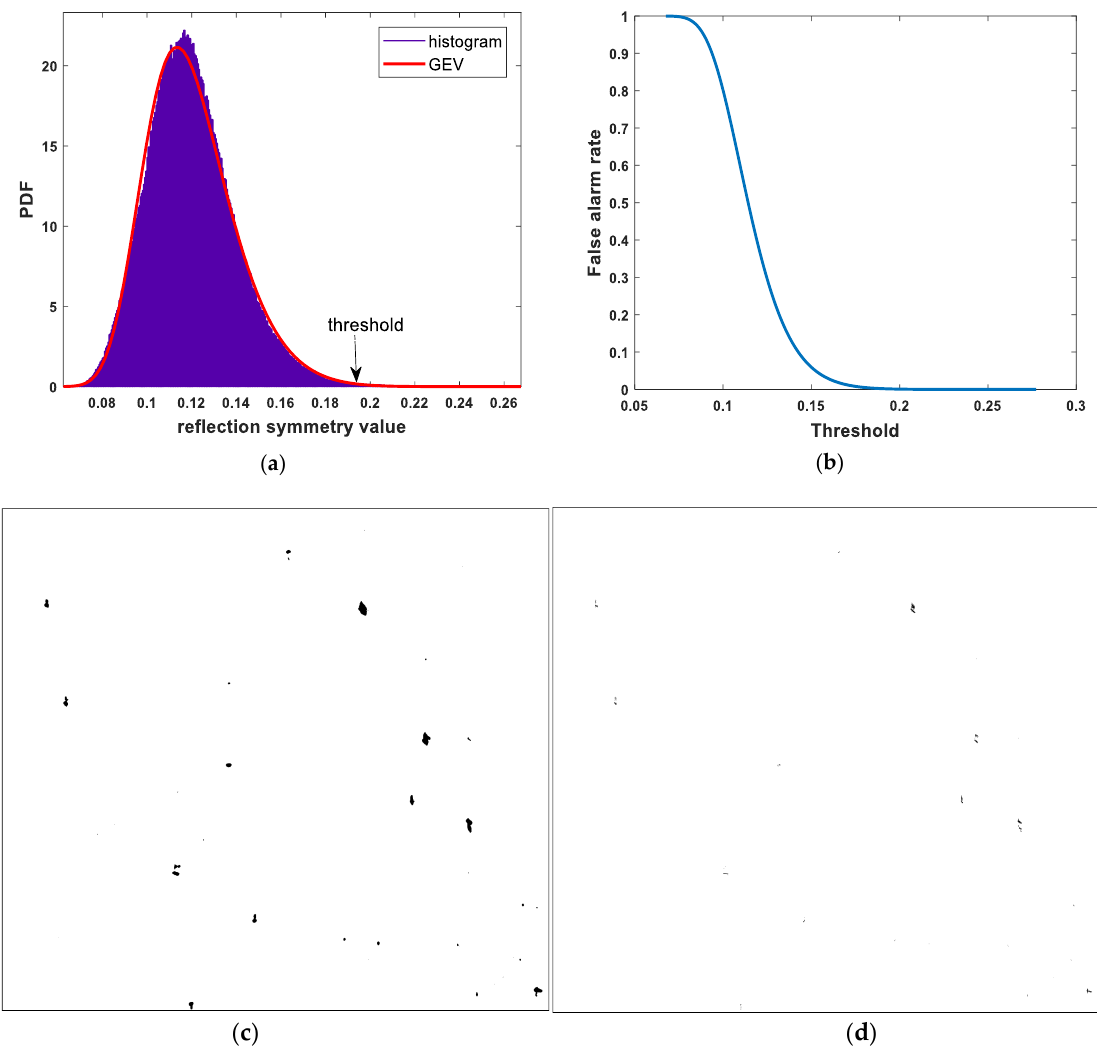
Figure 5. Data set 1. ( a ) PDF of normalized reflection symmetry and the fitted statistical distributions; ( b ) curve shows the relationship between false alarm rate and threshold; ( c ) GEV-based CFAR detection result on the reflection symmetry; ( d ) CFAR detection result on HV image.